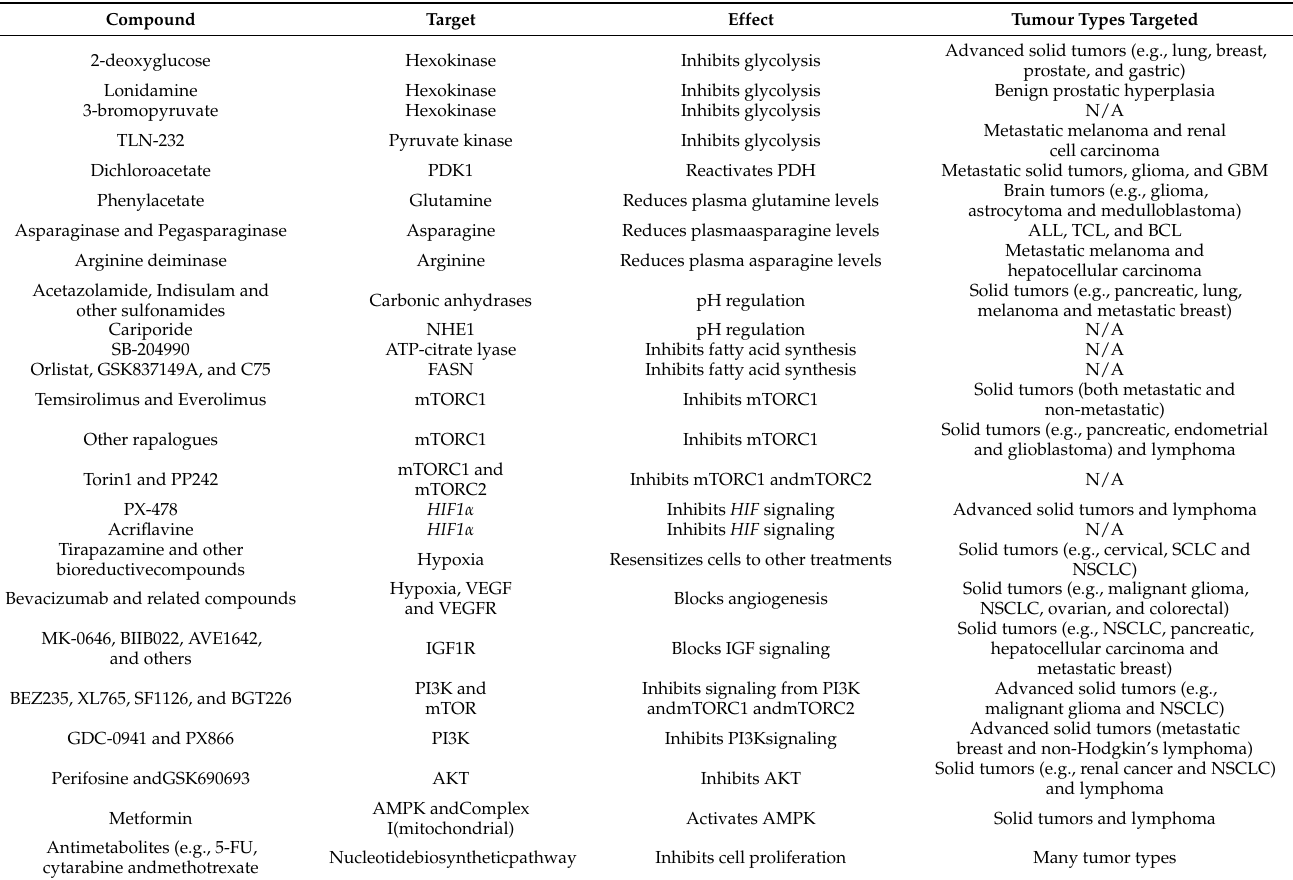
Table 1. Compounds targeting cancer metabolomics: The table lists the most common and recent small molecules, compounds, anti-metabolites, and